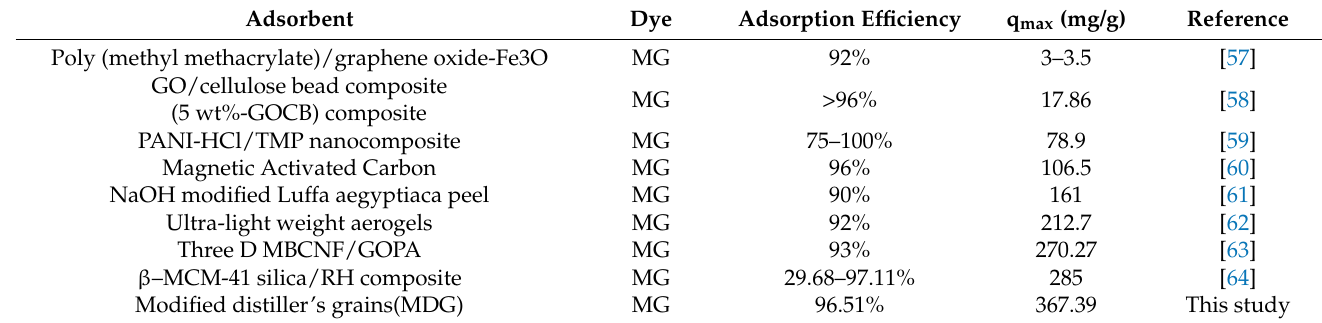
Table 7. Comparison of the developed MDG with the other reported materials for removal of